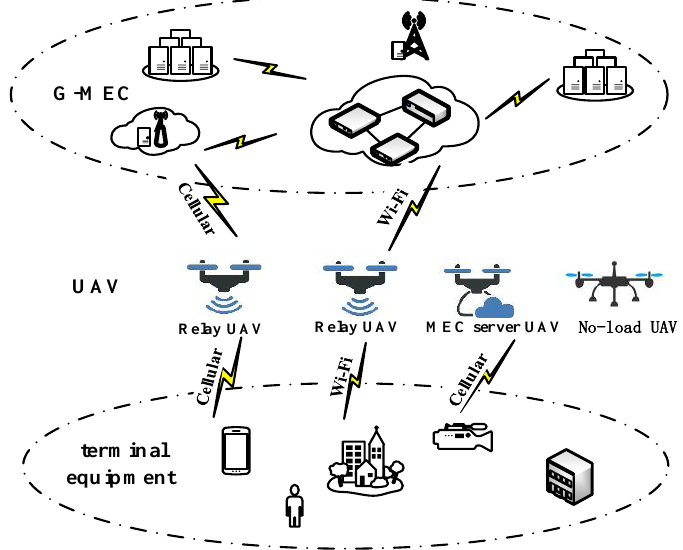
Figure 1. Multilevel offloading network environment.